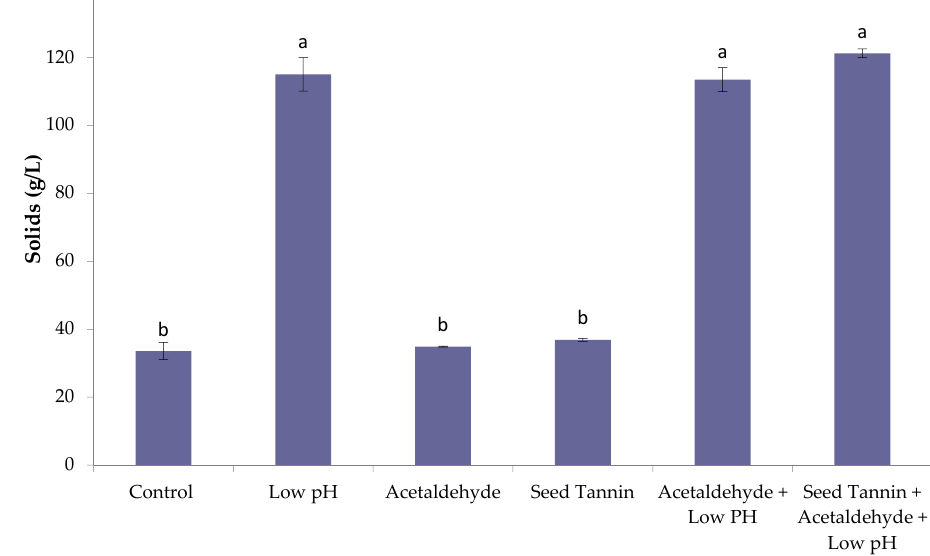
Figure 4. Precipitate formation in Rubired concentrate derived from conventional must heating (CMH) after 12 days of accelerated aging at 70 °C. Values are means of two replicates ± standard deviation; bars sharing the same letter are not significantly different; α = 0.05; n = 2; Tukey pairwise comparisons.